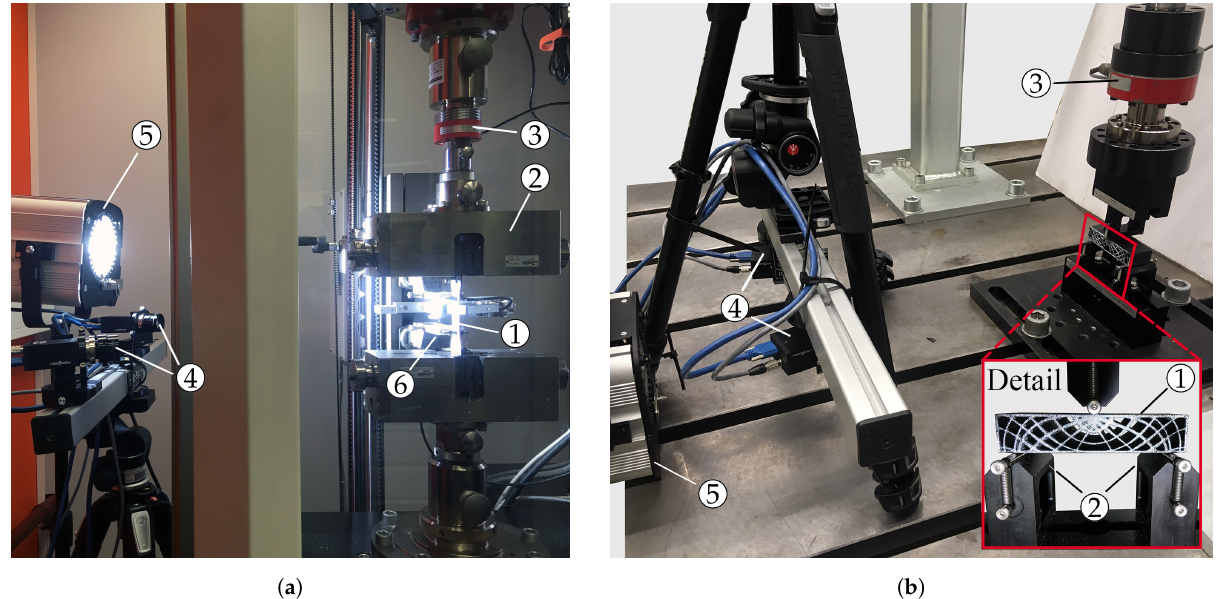
Figure 3. Experimental setups for ( a ) tensile and ( b ) bending tests including DIC system with respective specimen 1 , fixture 2 , load cell 3 , DIC cameras 4 , spotlight 5 and extensometer 6